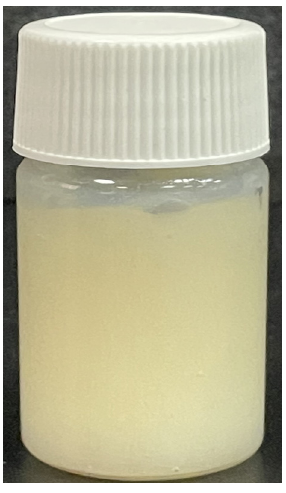
Figure 11. DSM-loaded NEs